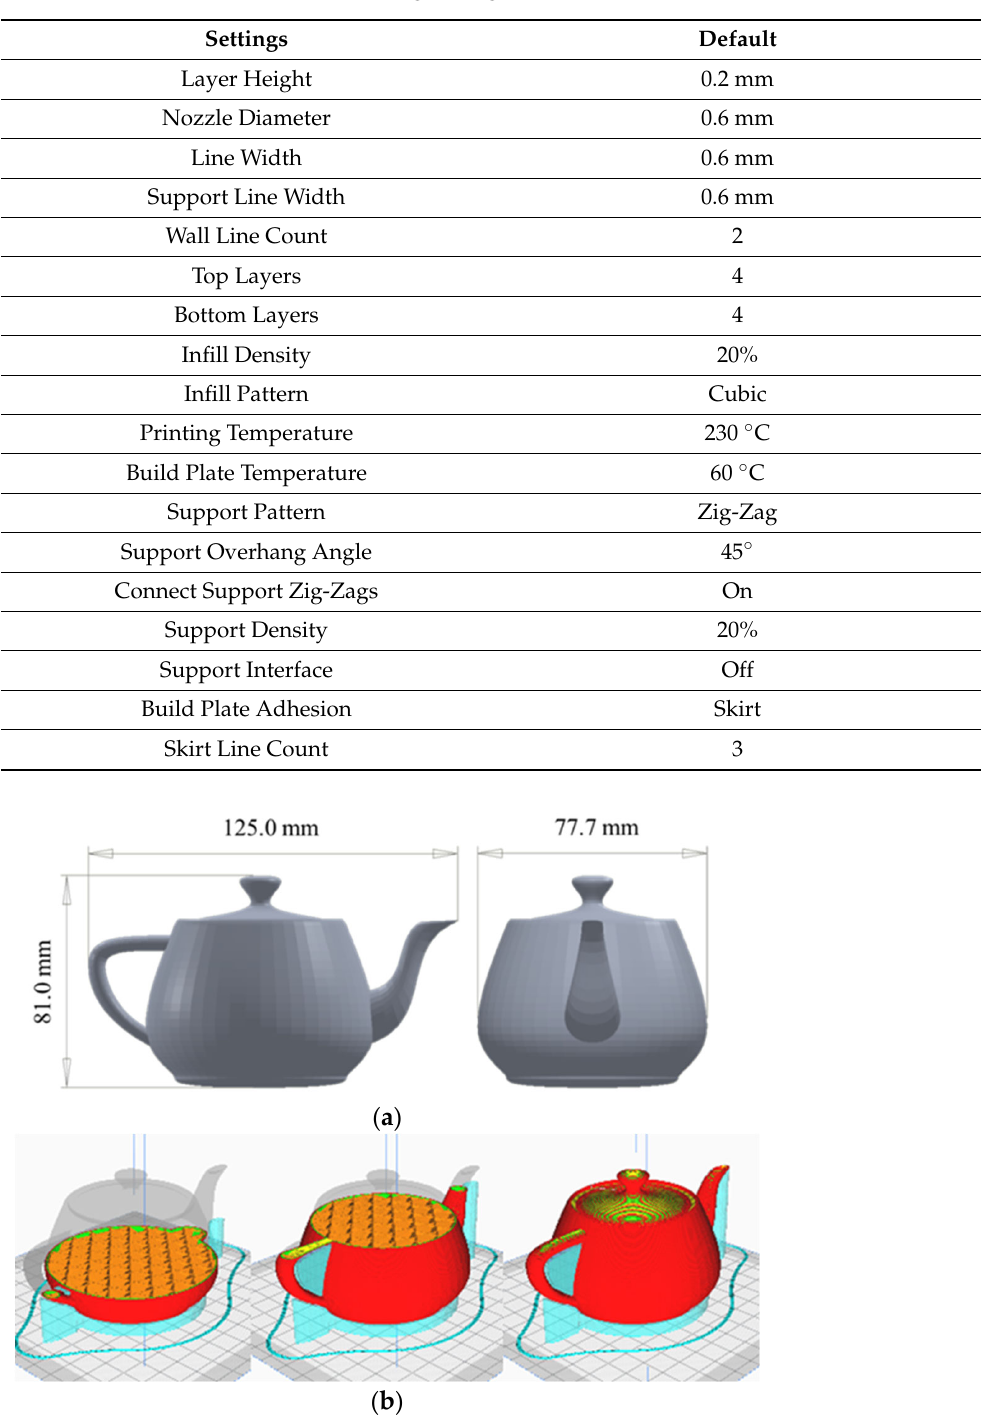
Table 2. Default Ultimaker CURA Printing Settings.